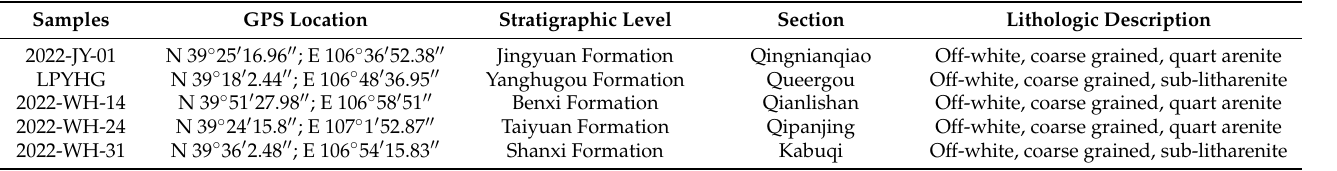
Figure 7. Standard ternary diagrams for Carboniferous to Lower Permian sandstone modal composition data from the Wuhai Coalfield. Petrologic classification ( a ) is according to Pettijohn [25]. Provenance fields ( b – d ) are from Dickinson [26]. Abbreviations: Qt, total quartz; Qm, monocrystalline quartz; Qp, polycrystalline quartz; K, K-feldspar; Pl, plagioclase; L, lithic fragment; Qt = Qm + Qp; F = K + Pl; Lt = L + Qp. Table 1. Petrography and sample location of sandstones for zircon U–Pb age